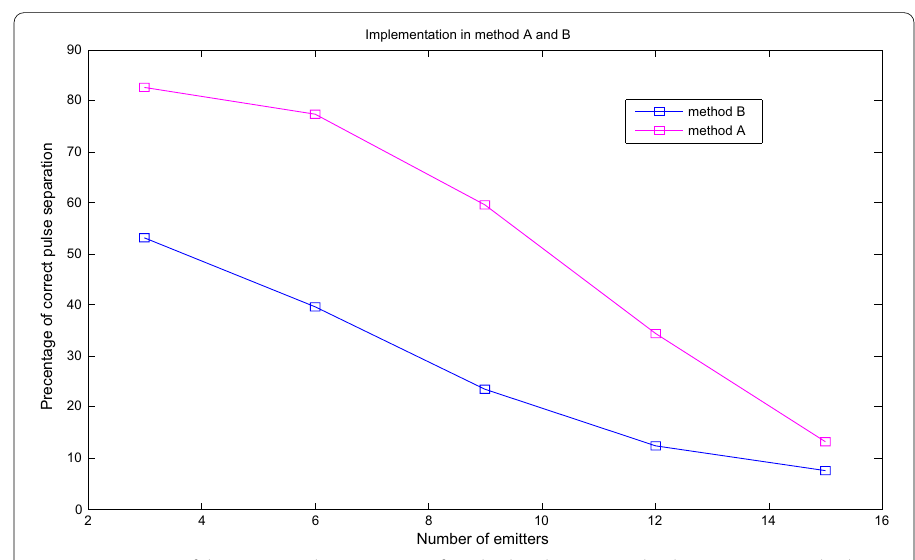
Fig. 7 Percentage of the correct pulse separation of method A (the proposed pulse separation method based on RF, PW, and TOA) and method B (the pulse separation method based on only